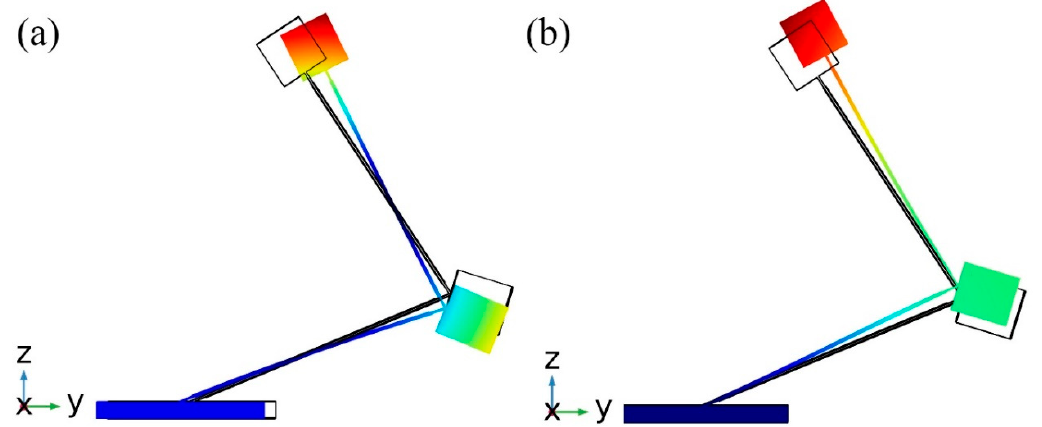
Figure 6. Vibration modes of bidirectional energy harvester; ( a )—vibration shape at 13.825 Hz; ( b )—vibration shape at 25.8 7Hz.